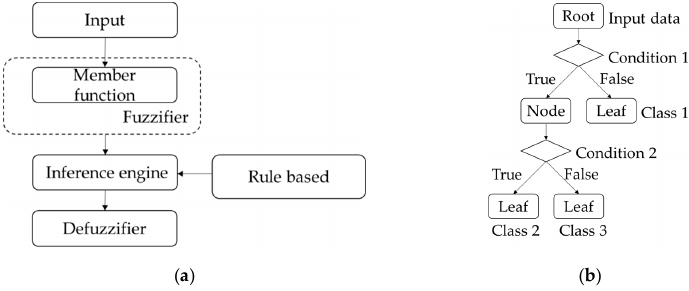
Figure 1. Two structures of decision making algorithms: ( a ) The fuzzy system includes fuzzifier, inference engine, expert rule and defuzzifer; ( b ) The binary decision tree includes the root, node and leaf.